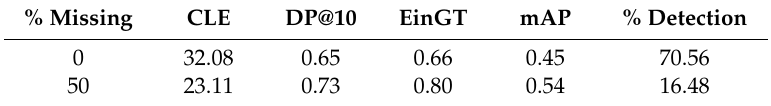
Table 1. Performance metrics for 0 and 50 percent missing pixels. JHU Balcony scenario.